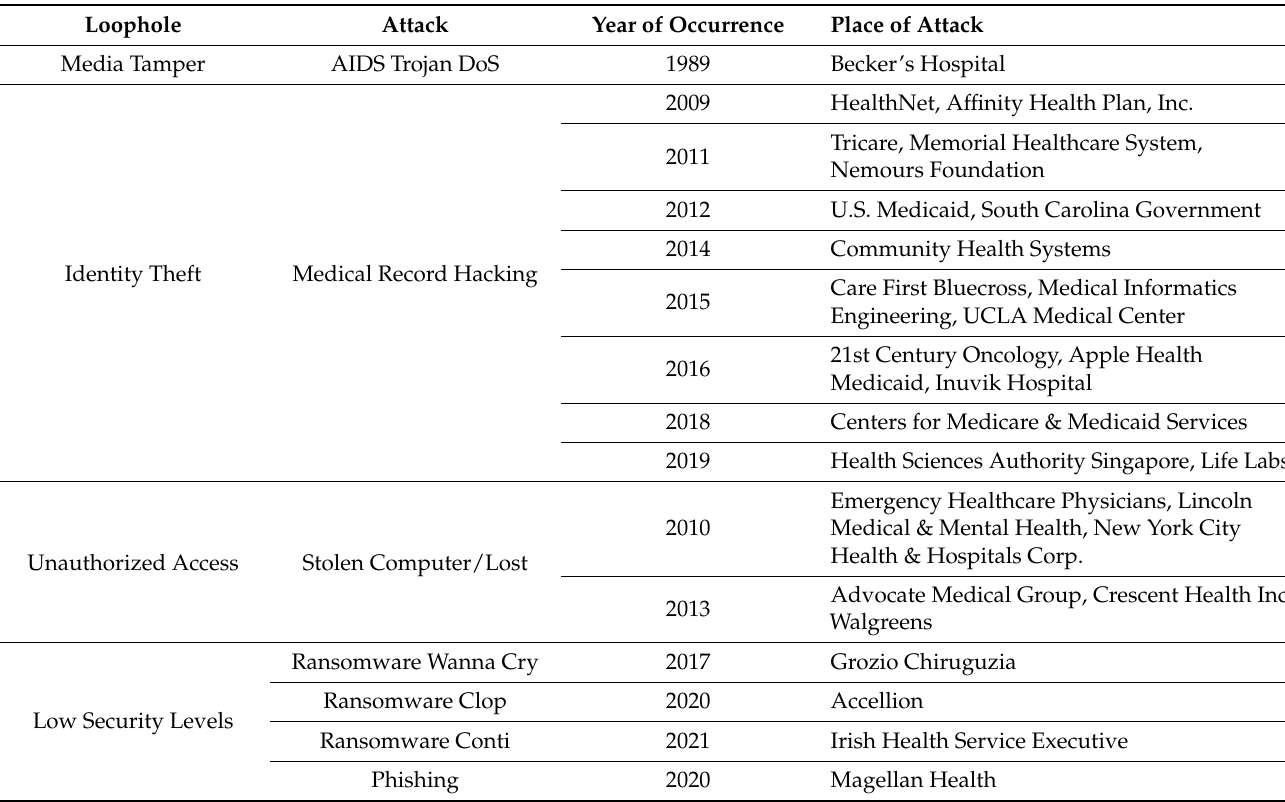
Table 3. Summary of cyberattacks over the years